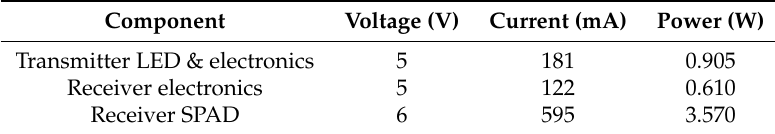
Figure 6. ( a ) Photograph of the micro-LED transmitter board (left), NANOBED “Flatsat” test bed (middle) and a standard 3U CubeSat chassis (right). ( b ) Schematic of the experimental setup for real time data transmission under simulated satellite power. Table 1. Typical power requirements of the communication